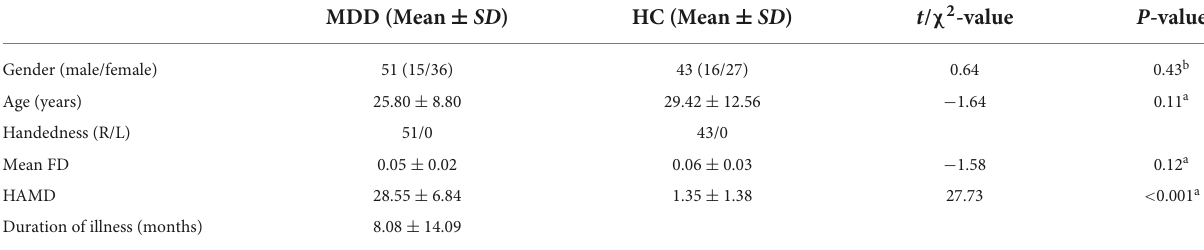
TABLE 1 Demographic and clinical data.